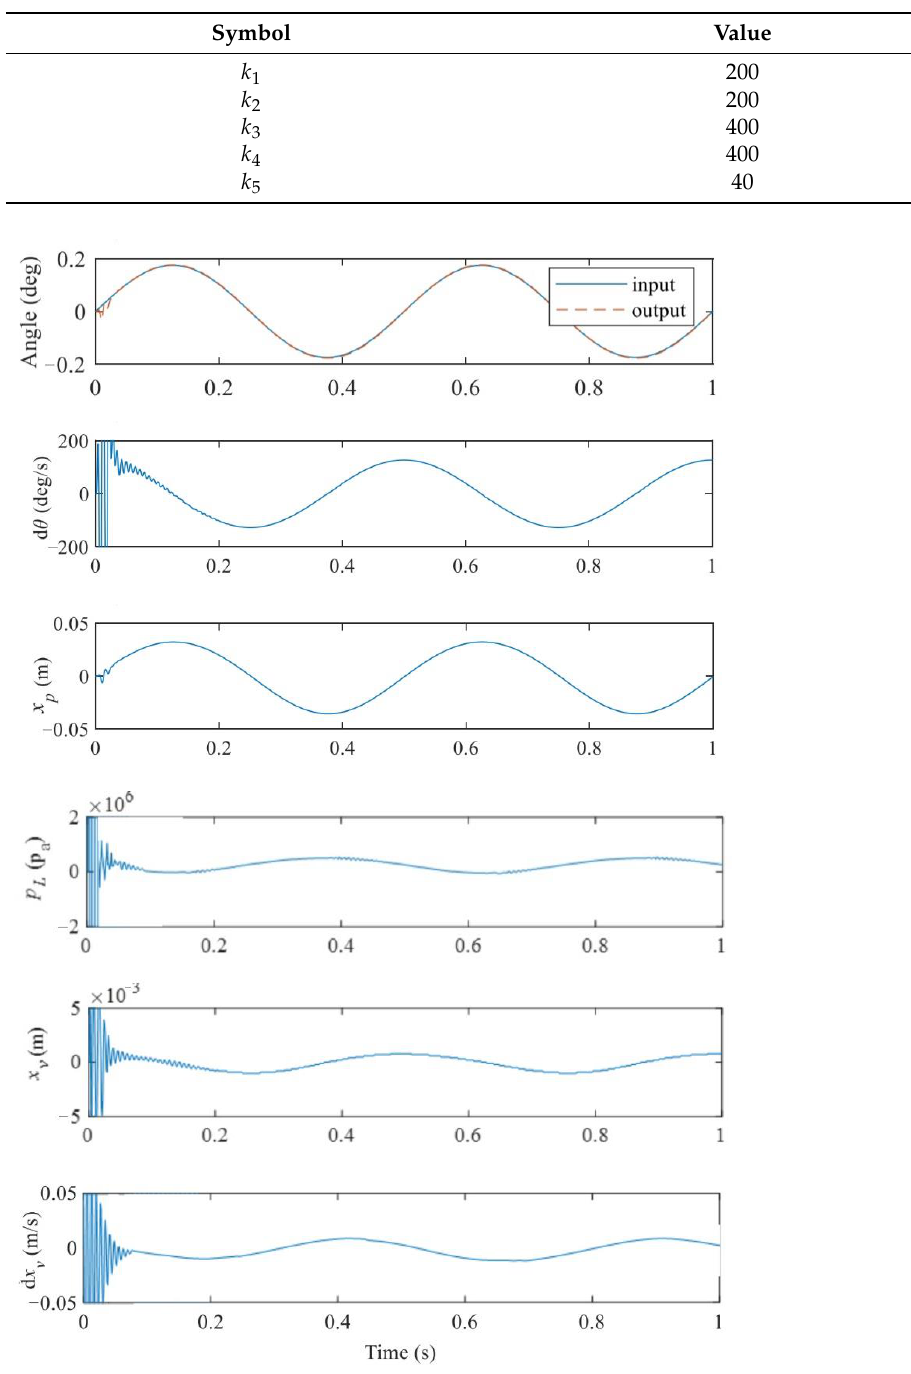
Figure 15. Backstepping HIL simulation curve (second set of control parameters).